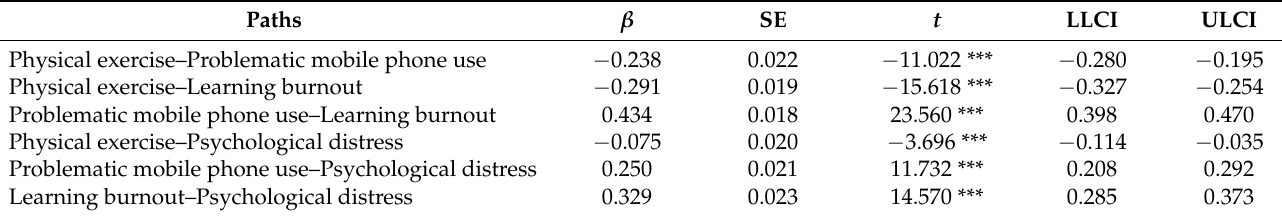
Table 3. Direct effects of variables in the serial multiple mediation model.